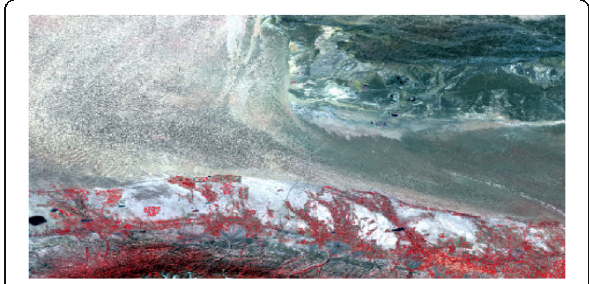
Fig. 2 Remote sensing image of Manasi County, Xinjiang